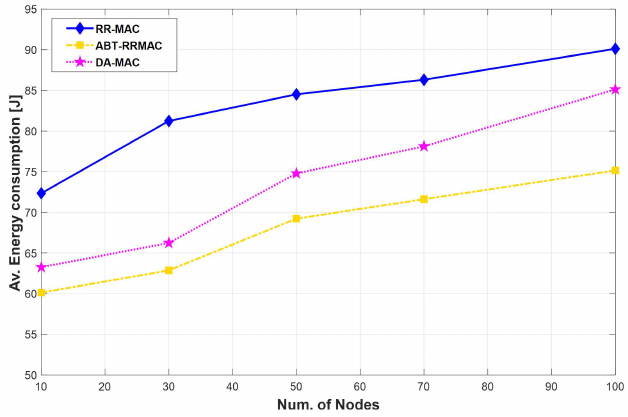
Figure 13. Energy